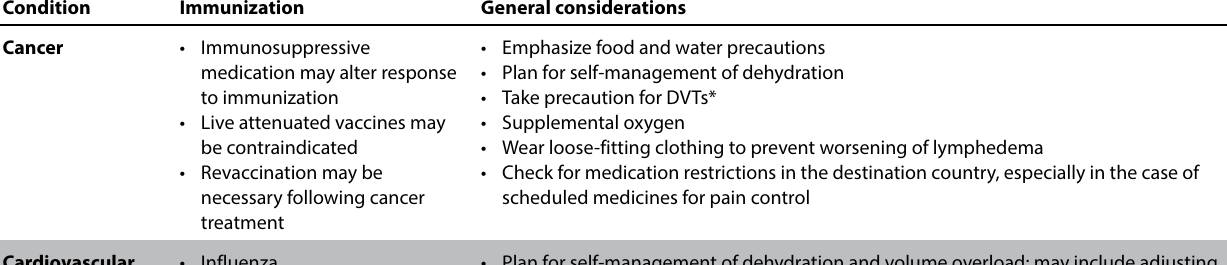
Table 3: Considerations for travellers with special medical conditions 33